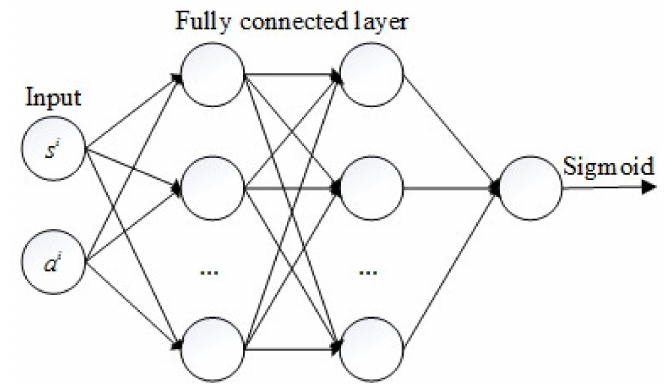
Figure 3. The architecture of the